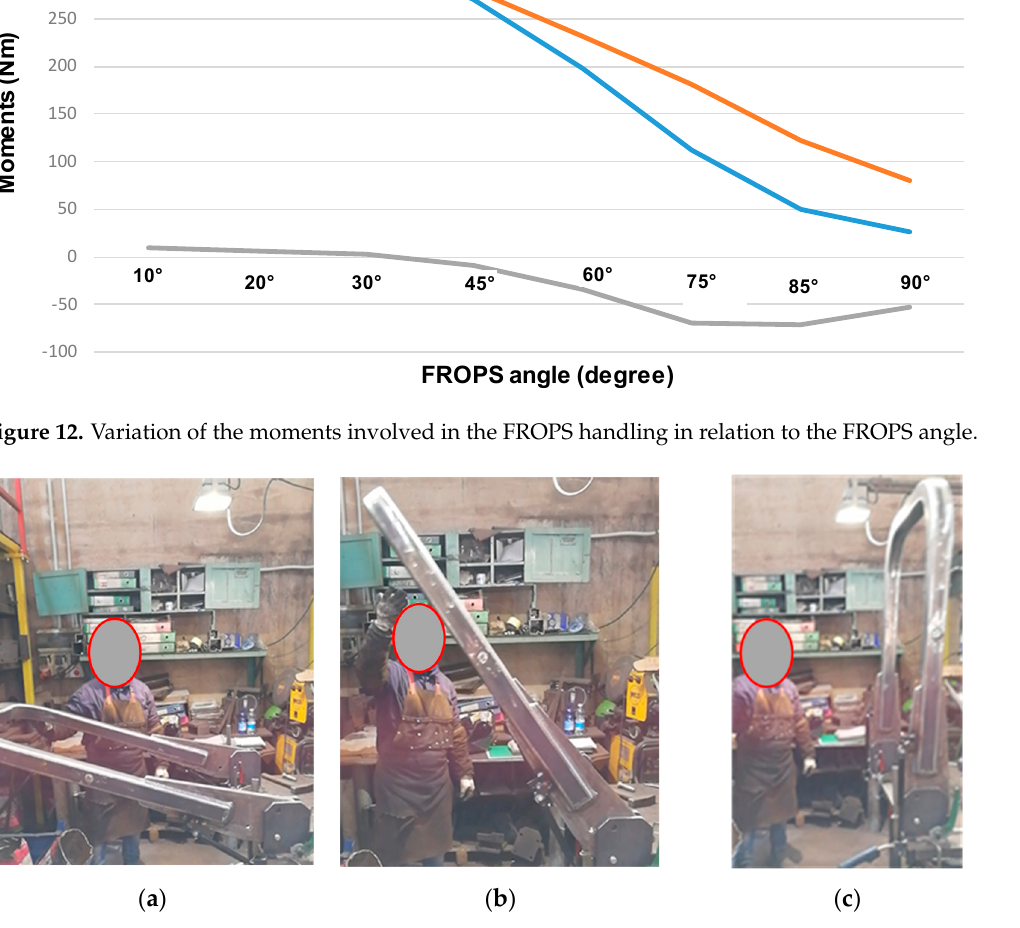
Figure 12. Variation of the moments involved in the FROPS handling in relation to the FROPS angle.